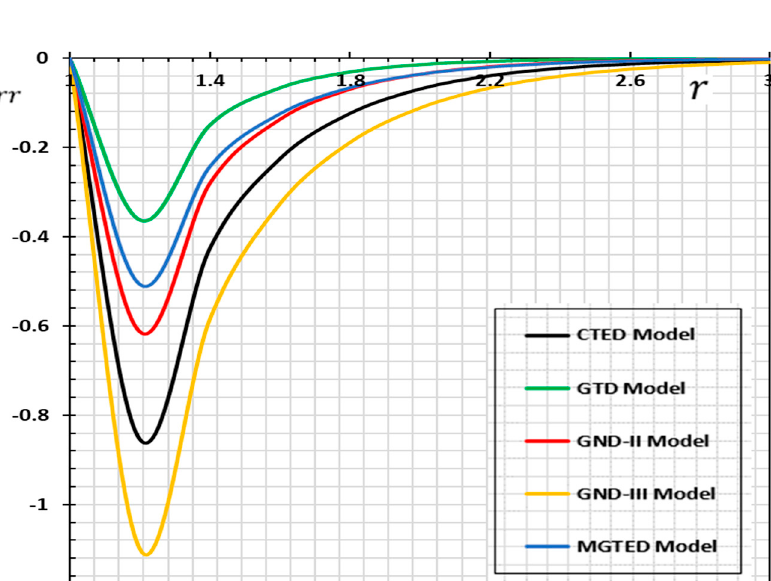
Figure 3. The radial stress σ rr for different thermo-diffusion models.